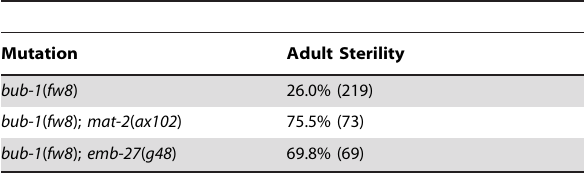
Table 4. Adult Sterility in Double Mutants of bub-1 ( fw8 ) with APC / C